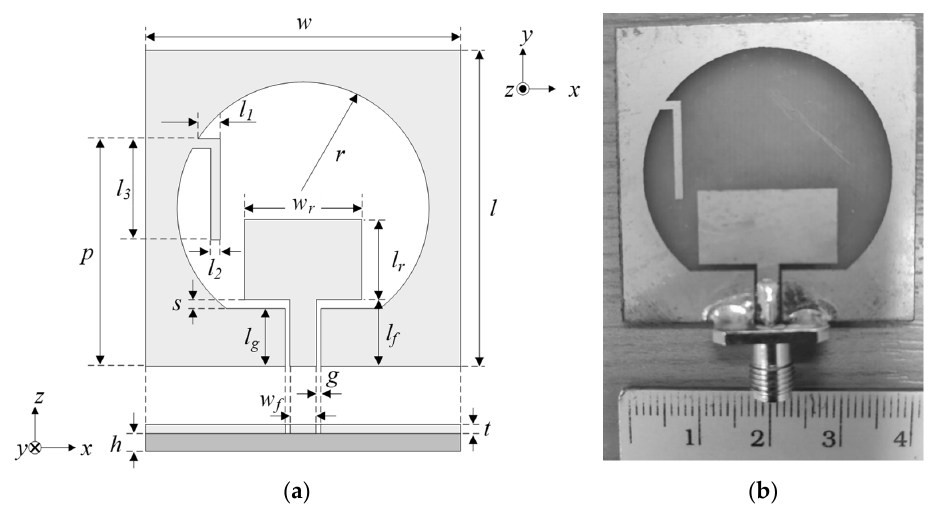
Figure 1. Structure of the proposed antenna: ( a ) schematic model ( b ) prototype.